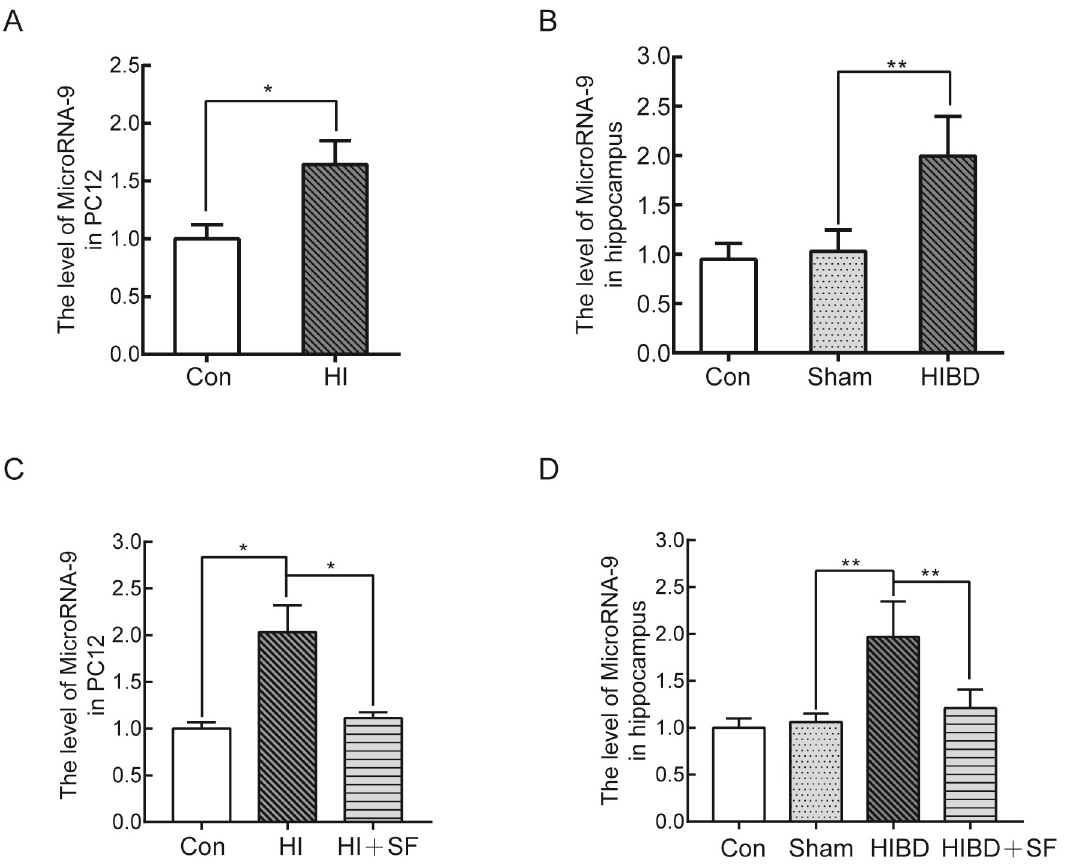
Fig 3. FA attenuated the upregulation of miR-9 under hypoxic-ischemic conditions in cultured PC12 cells and the rat hippocampus. (A) RT-PCR analysis of miR-9 expression in PC12 cells after HI. (B) RT-PCR analysis of miR-9 expression in the rat hippocampus after HIBD. �� P < 0.01, � P < 0.05 vs. control. (C) RT-PCR analysis of miR-9 expression in PC12 cells after FA treatment. (D) RT-PCR analysis of miR-9 expression in the rat hippocampus after FA treatment. �� P < 0.01, � P < 0.05 vs. HIBD. N = 4 for cell analysis and N = 6 for animal